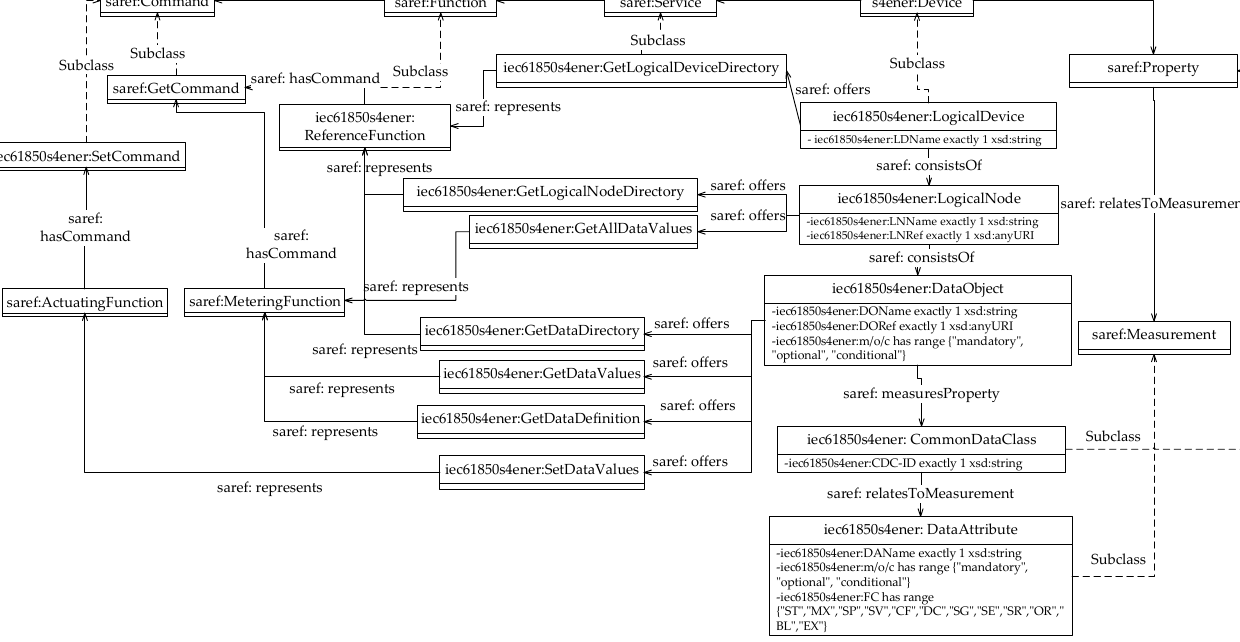
Figure 2. IEC61950 ‐ SAREF4ENER Ontology. Figure 2. IEC61950-SAREF4ENER